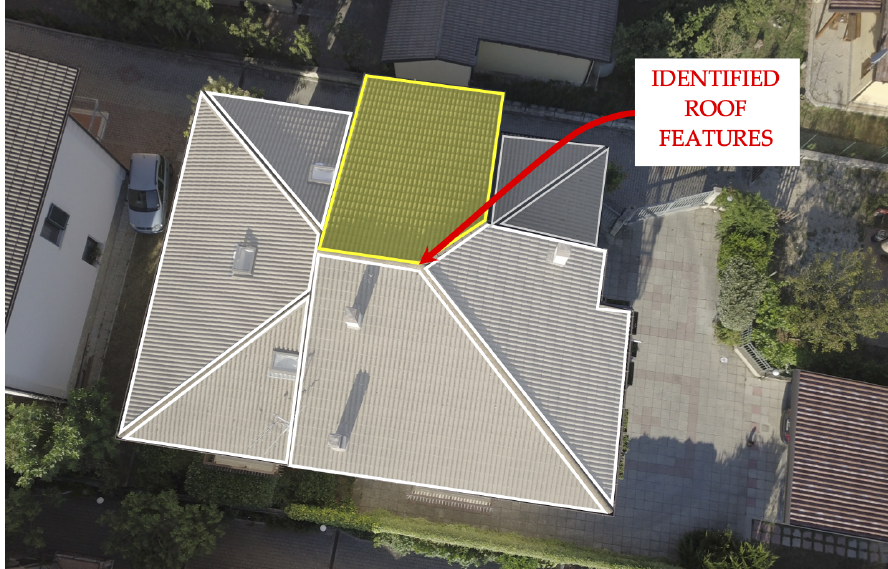
Figure 2. Top view of the building chosen for experimenting the approximation of roofs by planes.